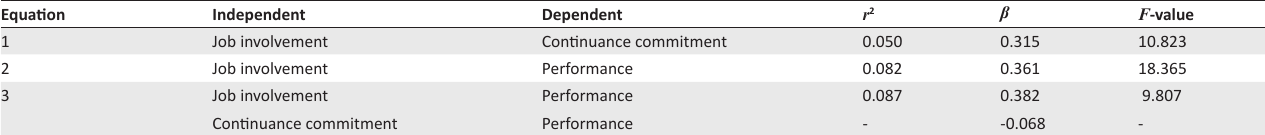
TABLE 5: Mediation effect of continuance commitment. Equation